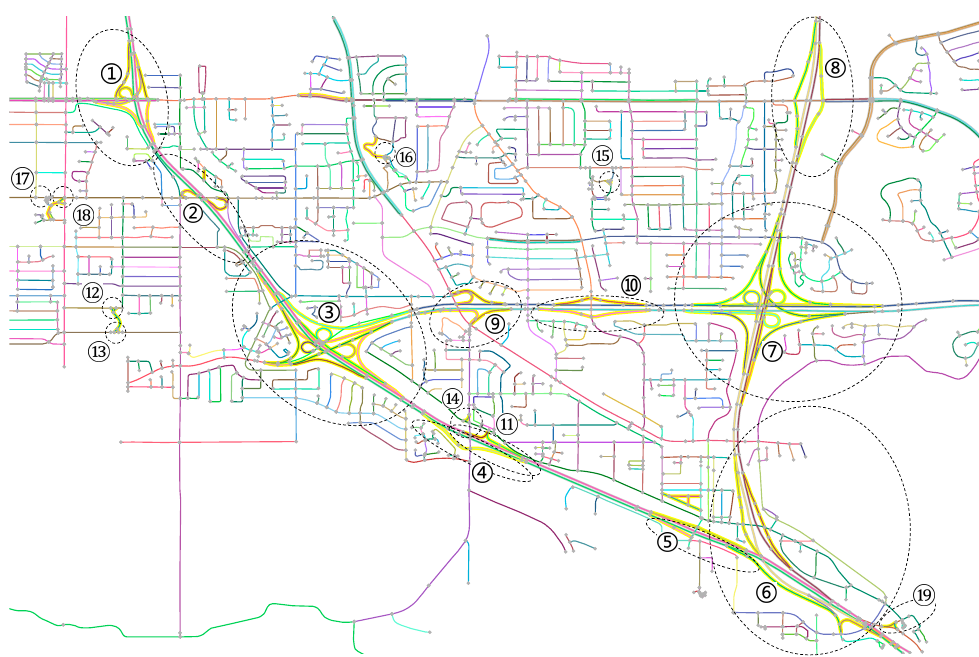
Figure 14. The test dataset and its preprocessing result without manual correction. The map used the same symbolization as that of Figure 9 except for the random stroke colors. The end points of the road segments of the raw data are represented by the light grey dots. The nineteen complex junctions to be identified are labeled from one to nineteen. The rough extents of the complex junctions are circled with the dashed ellipses. The strokes assembled are uniquely colored using a random coloring scheme. The paired dual lines are indicated by their light grey background. The secondary roads were indicated by their yellow background. ISPRS Int. J. Geo-Inf. 2020 , 9 , x FOR PEER REVIEW